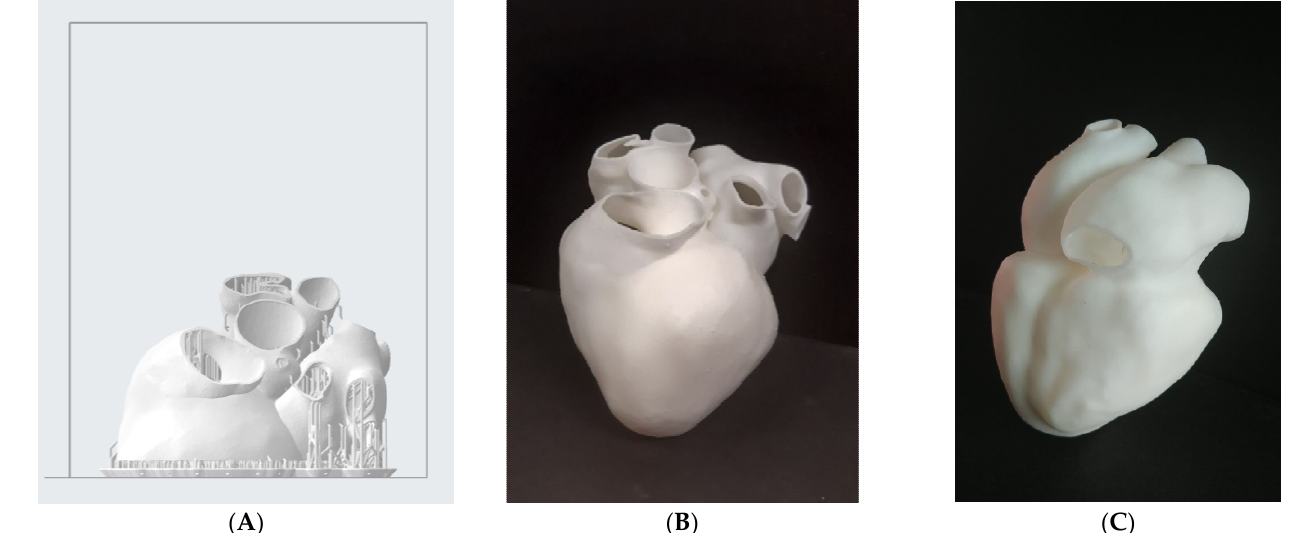
Figure 6. ( A ) “Superior” half of the hollow heart model disposed onto the printing platform (Preform 3.3); ( B , C ) the final print result, viewed according to two different orientations, as obtained after post-processing.